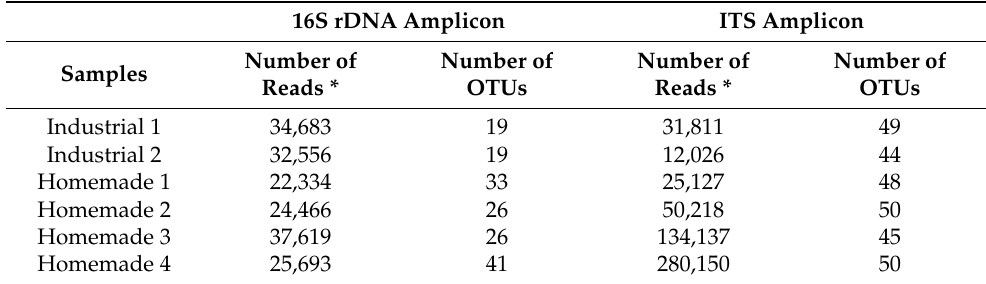
Table 1. Number of reads and OTUs for 16S rDNA and ITS amplicons of the Feta cheese samples.